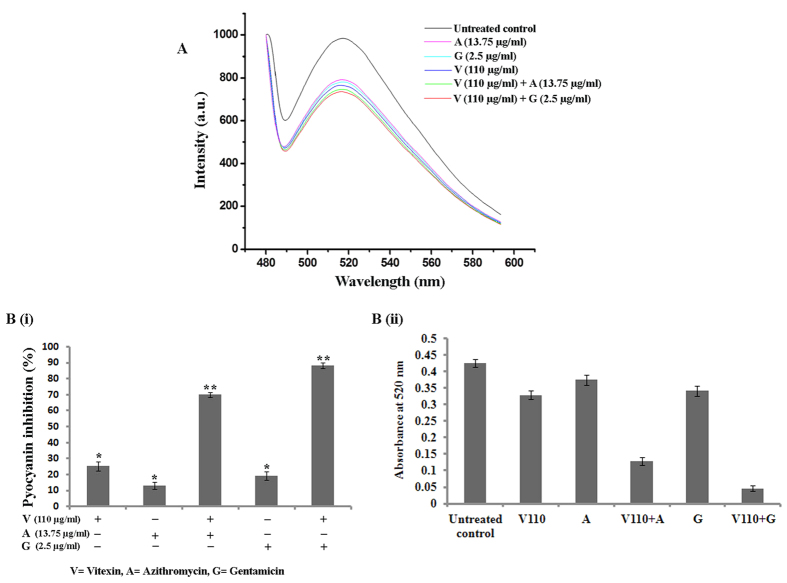
Effect of vitexin, combination of vitexin-azithromycin and vitexin-gentamicin on virulent factor production by P. aeruginosa.After treatment released pyoverdin were detected by fluorescence spectrophotometer and presented with respect to untreated control (A). Each experiment was performed using three independent cultures; one representative data set is shown here. Pyocyanin were detected by UV-vis spectrophotometer and presented as percentage inhibition (with respect to untreated control) (B(i)) and absorbance values at 520 nm (B(ii)). Each value is the average of triplicate assay where presented data is mean ± SD.